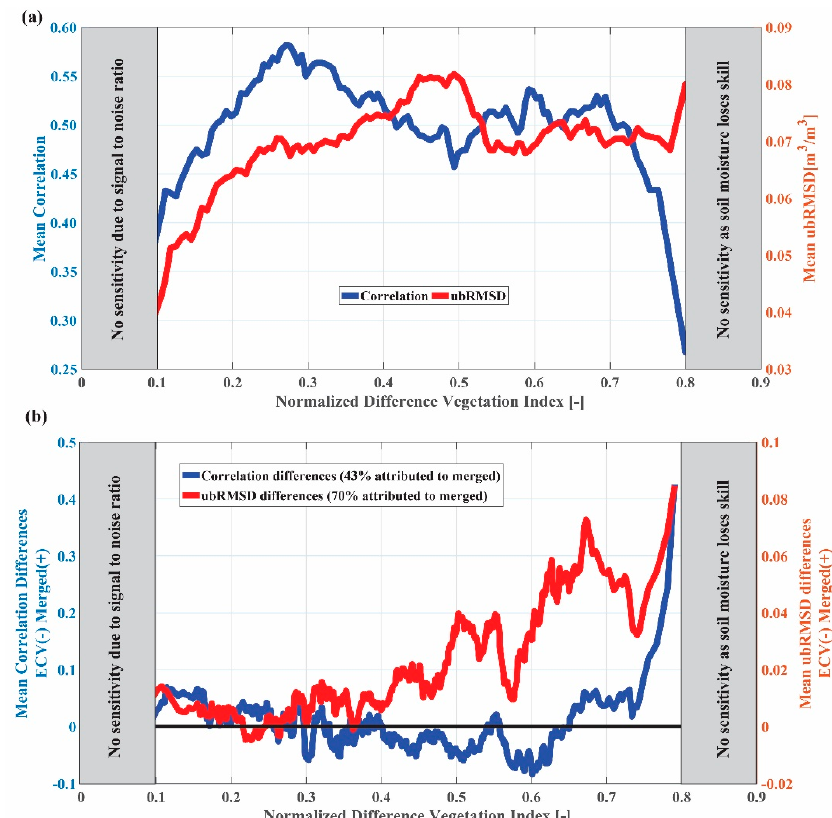
Figure 6. Evaluation over different vegetation densities (NDVI) of the merged product based ( a ) correlations and ubRMSD with the ISMN soil moisture measurements and ( b ) the differences between the correlations and ubRMSD with the in situ soil moisture and merged product and essential climate variable soil moisture (ECV). Positive values indicate higher correlations and smaller errors in the merged product, while negative values imply the same for ECV.